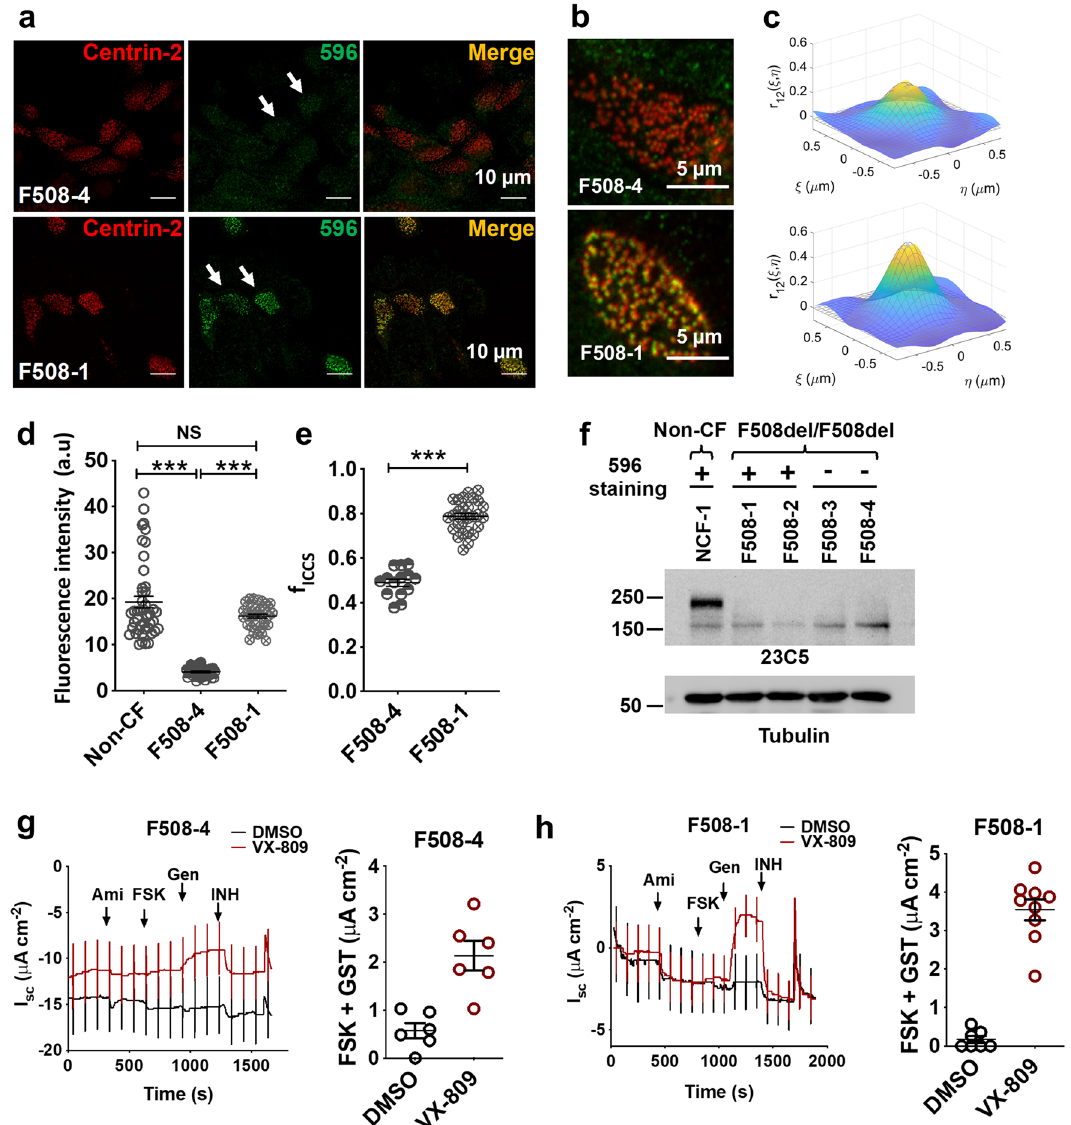
Figure 4. Apical 596 immunofluorescence in pHBE cells isolated from a subset of F508del/F508del patients. ( a ) Confocal images of apical immunofluorescence using well differentiated HBE cells from two F508del/F508del patients, one 596- (F508-4, top row) and the other 596+ (F508-1, bottom row). Colocalization with centrin-2 immunofluorescence confirmed expression in ciliated cells (merge). ( b ) Confocal images of the apical surface of F508-4 (top row) and F508-1 (bottom row) immunostained with 596 (green) and centrin-2 (red) antibodies used for image cross-correlation spectroscopy analysis. ( c ) Examples of spatial cross-correlation functions calculated using ICCS analysis from sub-regions (64 × 64 pixels) of the ciliated region images used to determine colocalization values; i.e. fractions of interacting particles per beam area in the green channel (M1) and the red channel (M2), for F508-4 (top) and F508-1 (bottom). ( d ) Summary of apical 596 immunofluorescence intensities in F508-4 and F508-1 cells. Intensity was normalized to the excitation power, (mean ± SD, n = 28—34, *** p < 0.0001, one-way ANOVA). ( e ) Colocalized fraction f ICCS extracted from ICCS analysis (mean ± SD, n = 14–26, *** p = 6 × 10 −16 , t-test). ( f ) Immunoblot of lysates from well differentiated F508del/F508del HBE cells probed with antibody 23C5 against the R domain of CFTR. ( g , h , these images are from one blot). Short-circuit current recordings and summaries of maximal cAMP responses after 24 h pretreatment with vehicle (DMSO, black) or the corrector VX-809 (1 µM, red). Cells were exposed sequentially to amiloride (Ami; 100 µM), forskolin (FSK; 10 µM) and genistein (Gen; 50 µM). Currents were inhibited using CFTR inh -172 (INH; 10 µM). Note that under control conditions (DMSO), F508-1 cells with apical 596 immunofluorescence had smaller stimulated currents compared to F508-4 cells that were